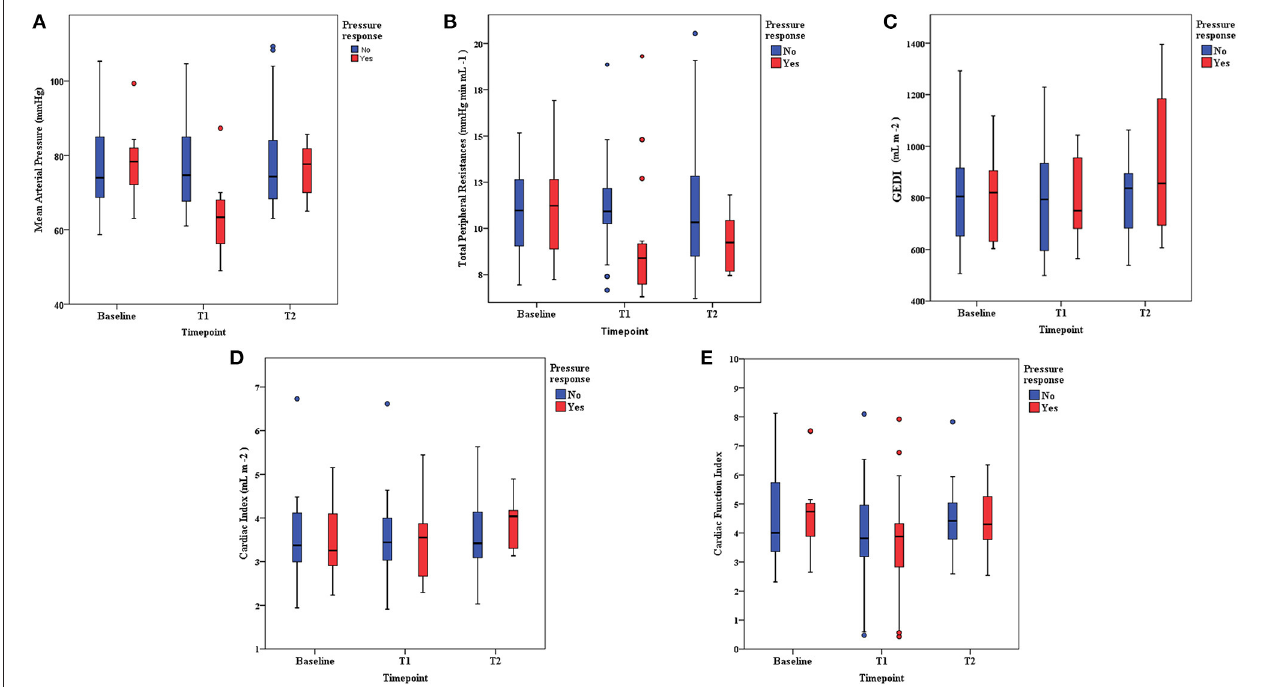
FIGURE 2 | (A) Mean arterial pressure evolution from baseline to each intervention. Pressure responders vs. non-responders. T1 = norepinephrine dosage decrease. T2 = Fluid expansion. (B) TPR (total peripheral resistances) evolution from baseline to each intervention. Pressure responders vs. non-responders. T1 = norepinephrine dosage decrease. T2 = Fluid expansion. (C) GEDI (indexed global end diastolic volume) evolution from baseline to each intervention. Pressure responders vs. non-responders. T1 = norepinephrine dosage decrease. T2 = Fluid expansion. (D) Cardiac index evolution from baseline to each intervention. Pressure responders vs. non-responders. T1 = norepinephrine dosage decrease. T2 = Fluid expansion. (E) CFI (cardiac function index) evolution from baseline to each intervention. Pressure responders vs. non-responders. T1 = norepinephrine dosage decrease. T2 = Fluid expansion.